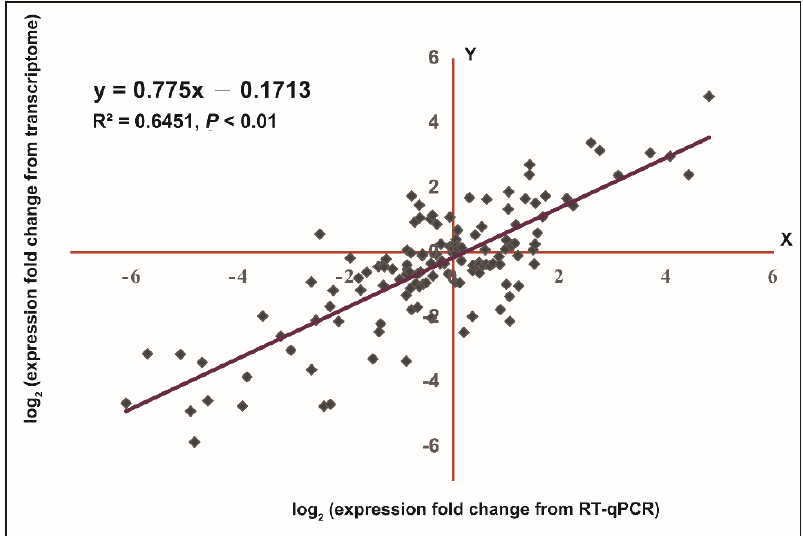
Figure 7. Correlation between the data from the ONT sequencing and RT-qPCR.